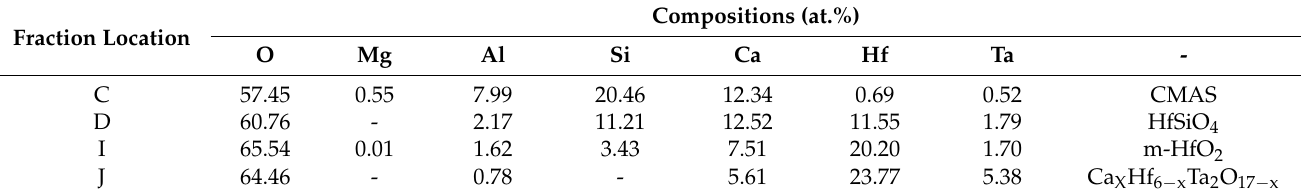
Figure 10. ( a ) A cross-sectional BSE image of Hf 6 Ta 2 O 17 ceramic after CMAS corrosion at 1300 °C for 8 h; ( b ) magnified image of the dashed rectangle in Figure 10a. Table 3. Chemical compositions of the marked regions in Figure 10b.